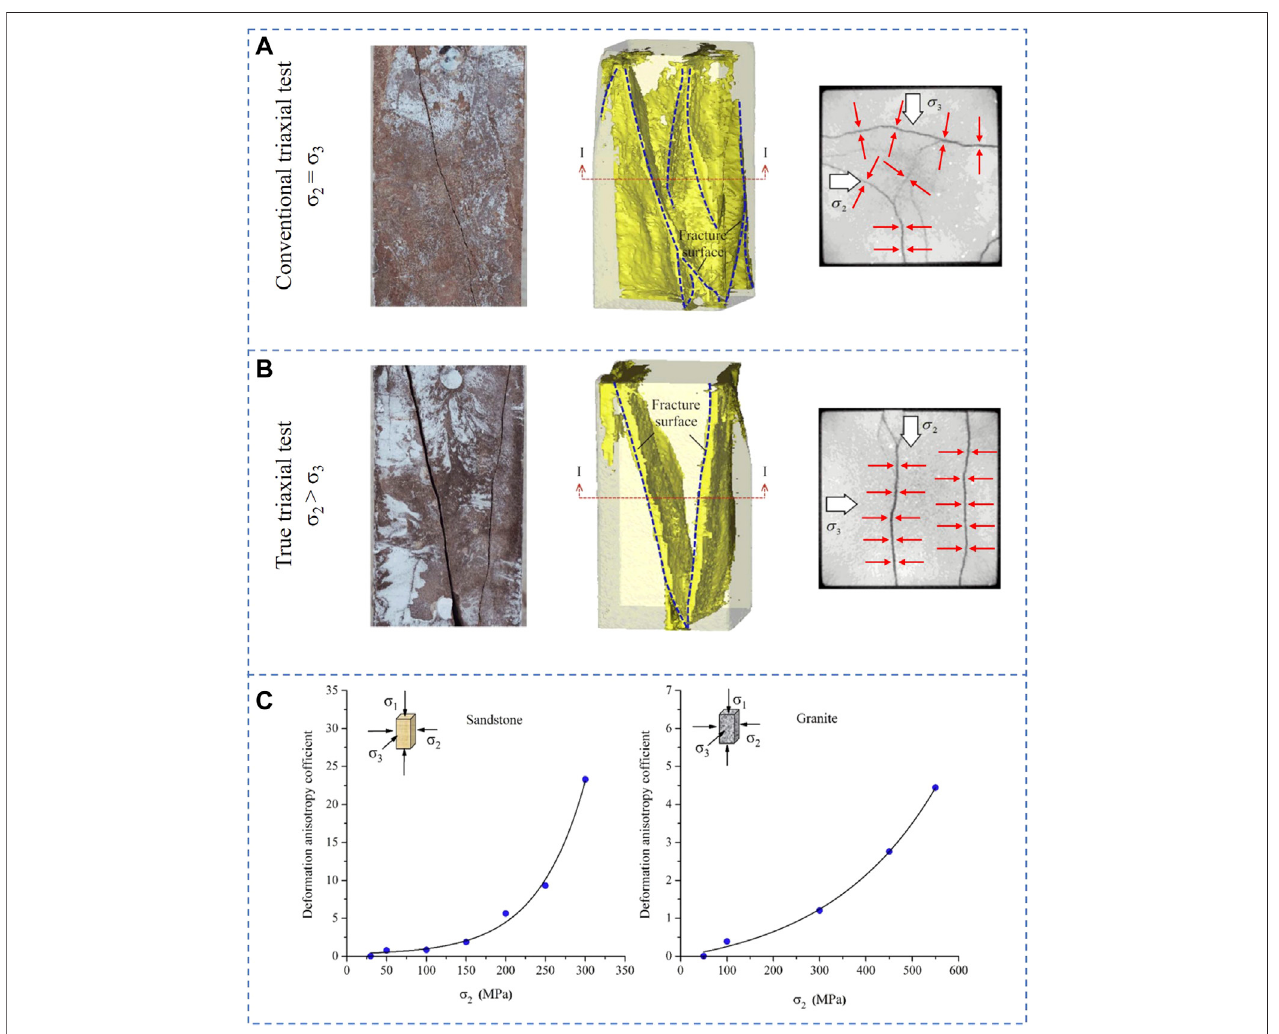
FIGURE 12| Failure difference ofhard rock based on comparison between the conventional triaxial test and true triaxial test (revised form Luet al., 2018 and Feng et al., 2019). (A) Conventional triaxial stress state, (B) true triaxial stress state, and (C) differential stress-induced anisotropy failure analysis.